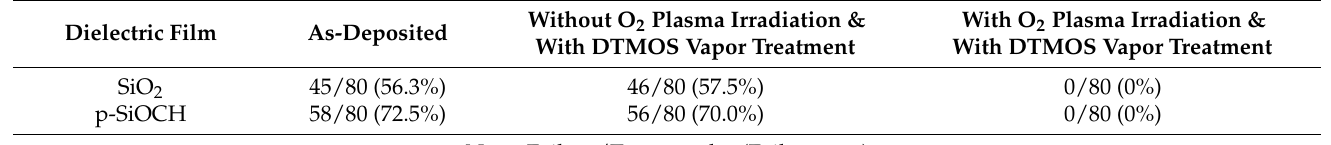
Table 1. SiO 2 and p-SiOCH films after O 2 plasma and DTMOS vapor